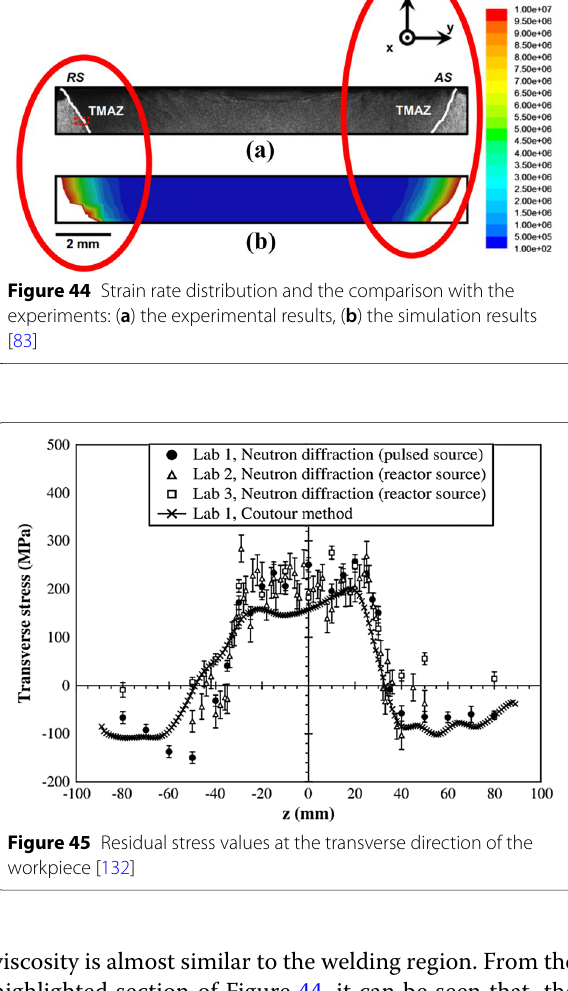
Figure 43 Strain rate values across the X direction [84]